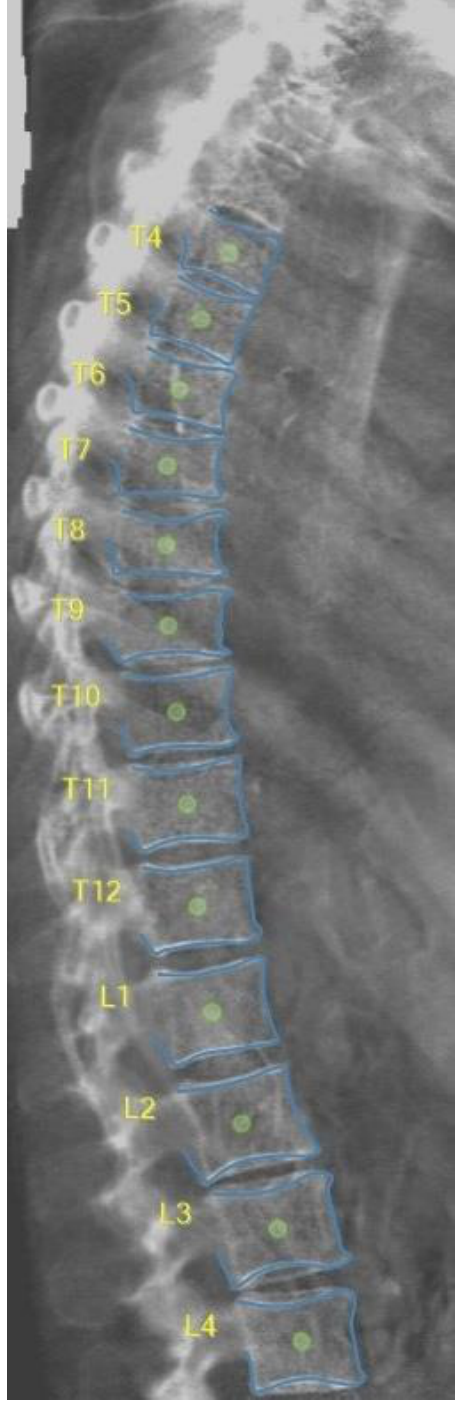
Figure 1. Lateral DXA VFA illustrating all 33 semi-automatically identified points used to outline each vertebral body produced by AVERT ® .